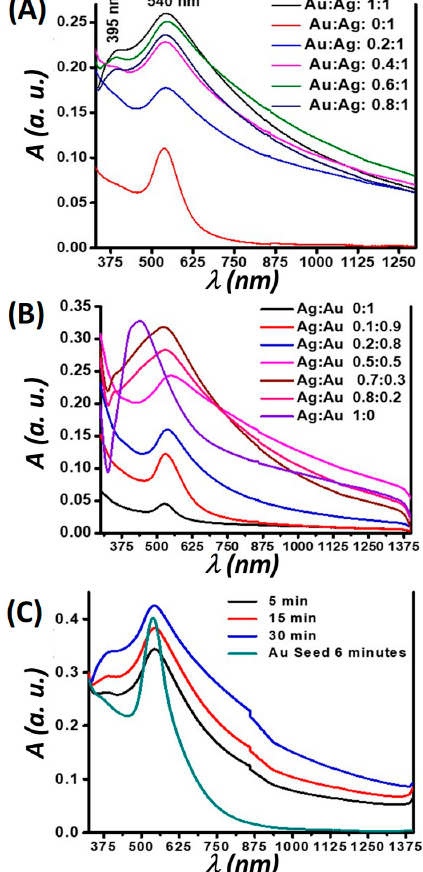
Figure 2. Plots of absorption spectra of the Au-Ag nanotwin NPs prepared using 1 mM of the Au(I) precursor as the seed, irradiation using Source 1 for 90 min in ( A ) and ( B ). The volume of 10 mM AgNO 3 feed solution added is varied for constant volumes of 1 mM Au in (A) and relative variation of seed to feed in ( B ). ( C ) Shows SPR spectra of 1 mM Au(I) precursor seed created by 6 min of irradiation using Source 2 followed by time-dependent irradiation of the same seed solution at a 1:1 volume ratio with 10 mM AgNO 3 feed using Source 1. All ratios represented here in A and B are volume ratios of Au(I) and Ag(I) precursor concentrations.